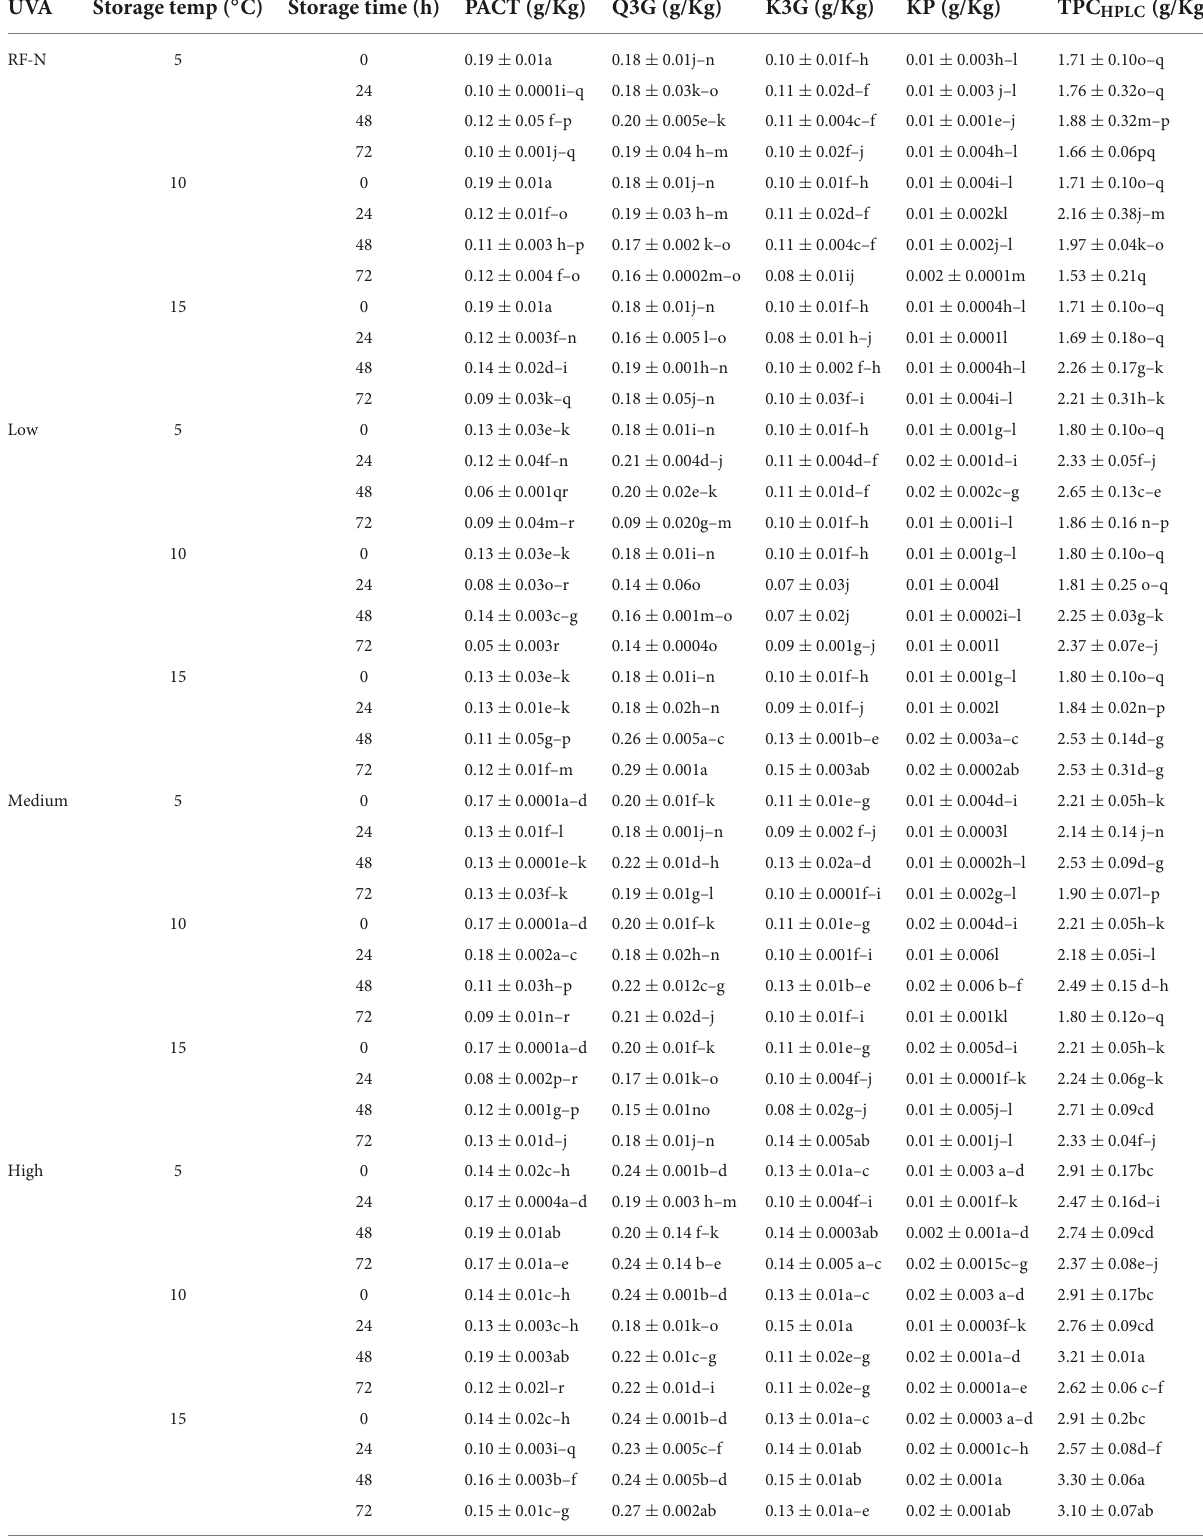
TABLE 1B Changes in the individual phenolic compound concentration of strawberry by–products as affected by UVA dose, storage time, and temperature. UVA Storage temp ( ◦ C) Storage time (h) PACT